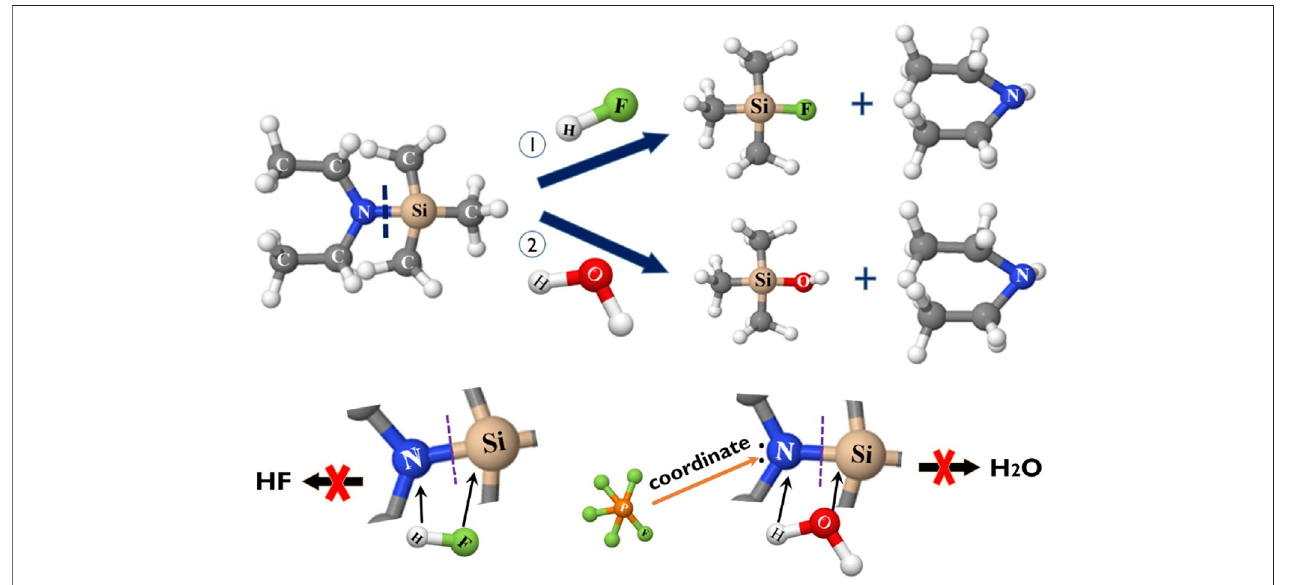
FIGURE 1 | The molecule structure of DETMSA and the reactions (1) with HF and (2) with H 2 O by breaking the Si – N bond.